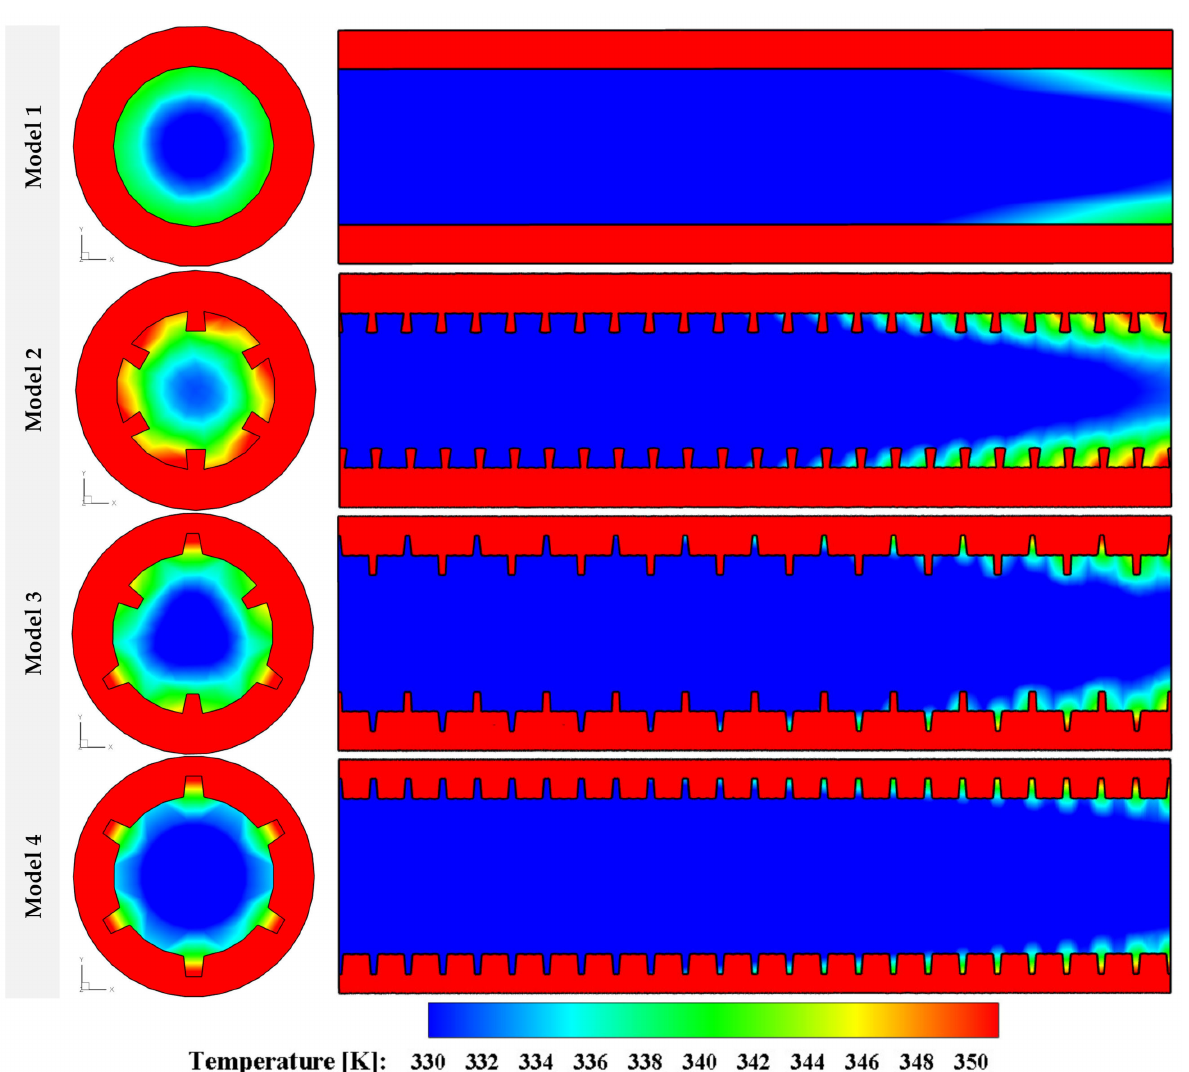
Figure 10. Contours of temperature at outlet and a slice (X = 0) for various models at P = 500 mm and V Inlet = 0.1256